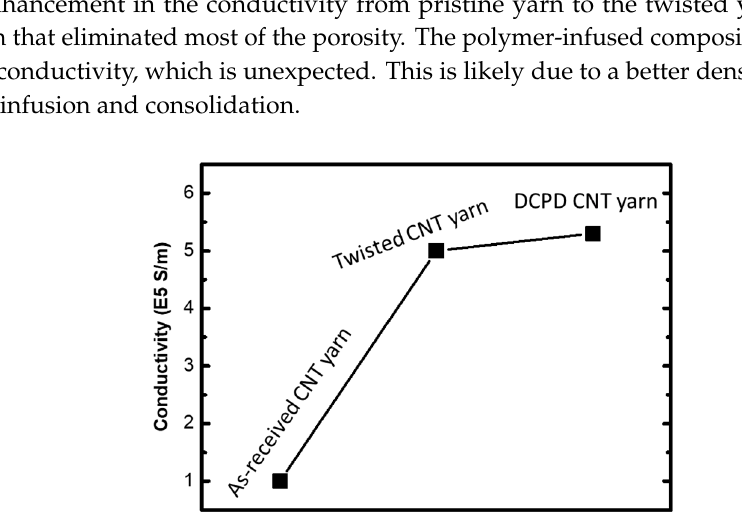
Figure 8. Electrical conductivity of as-received CNT yarn, twisted yarn, and DCPD–CNT yarn.